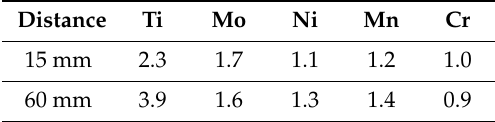
Figure 16. The variation of the segregation index measured with EDX plotted against distance from the billet surface to the center. Table 4. Segregation index of alloying elements 15 mm and 60 mm from the billet surface, corresponding to the SDAS values 20 µ m and 70 µ m.